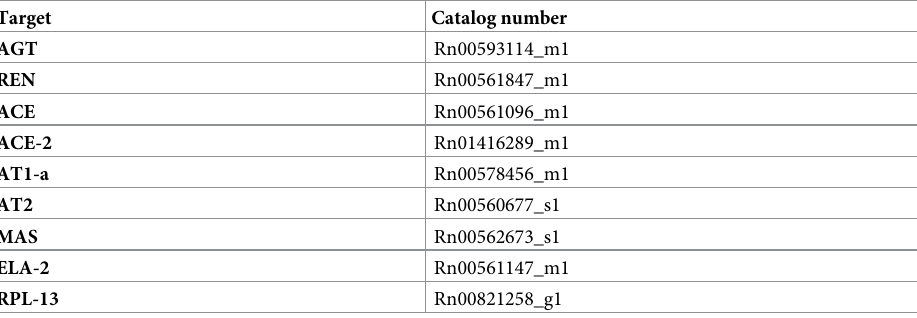
Table 1. Primers used for quantitative gene